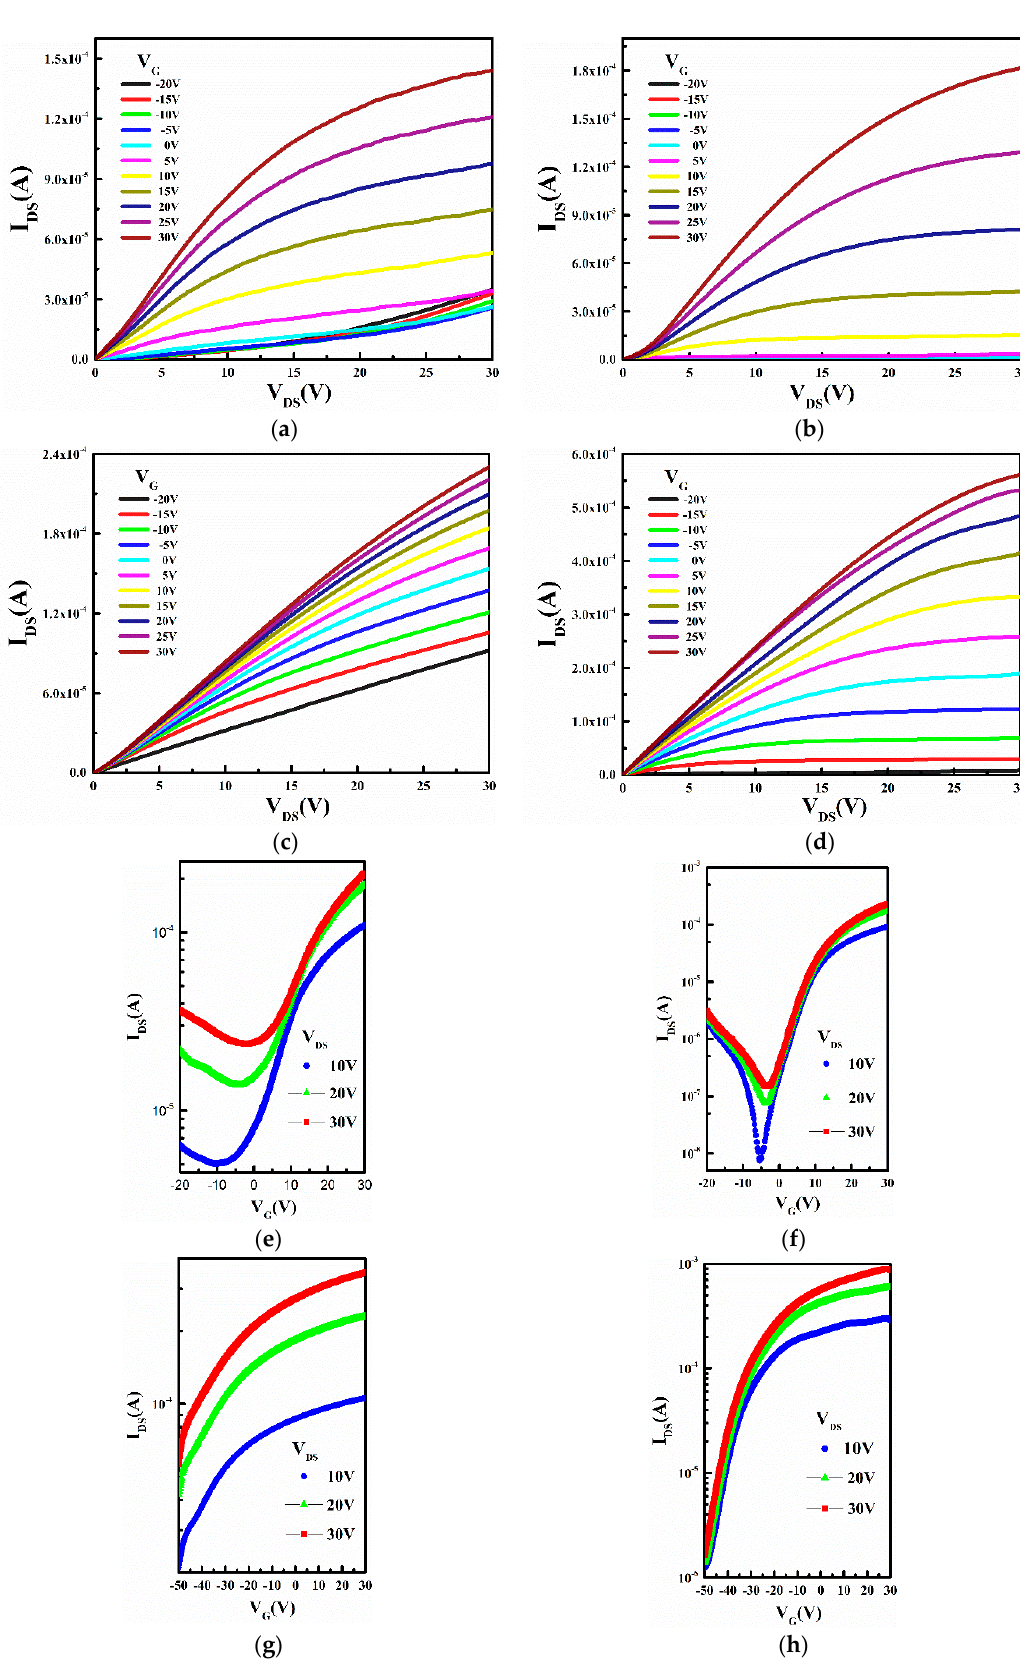
Figure 4. Output curve of ( a ) Au, ( b ) Ag, ( c ) Al, ( d ) Cu and transfer curve of ( e ) Au, ( f ) Ag, ( g ) Al, ( h ) Cu.